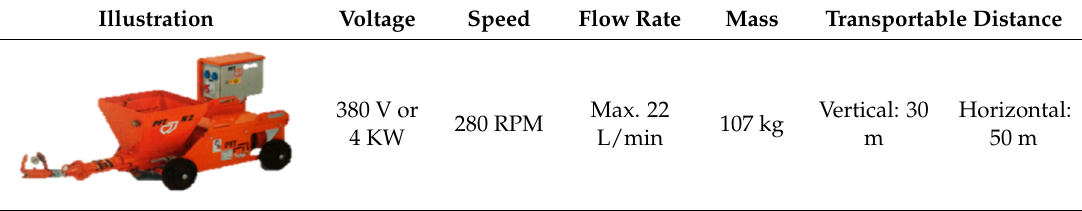
Table 3. SPRG Screw-Mixing Apparatus Specifications.